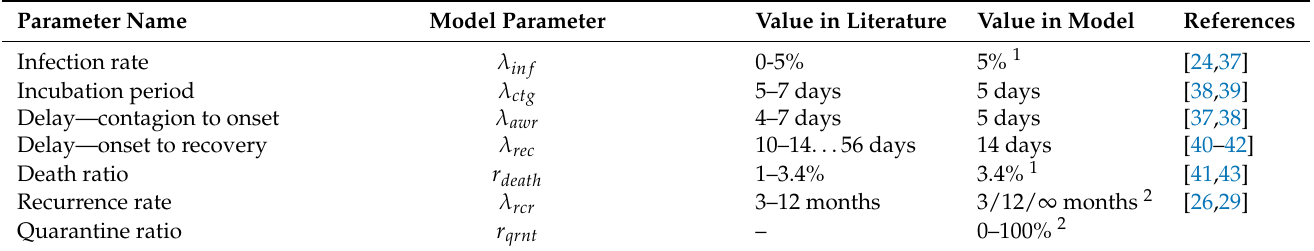
Table 1. Parameter setting for the SICARQD epidemic model, highlighting the values found in the literature, the values chosen in our model, and the supporting references. 1 Assumed worst case scenario based on literature review. 2 Parameters are being investigated in our